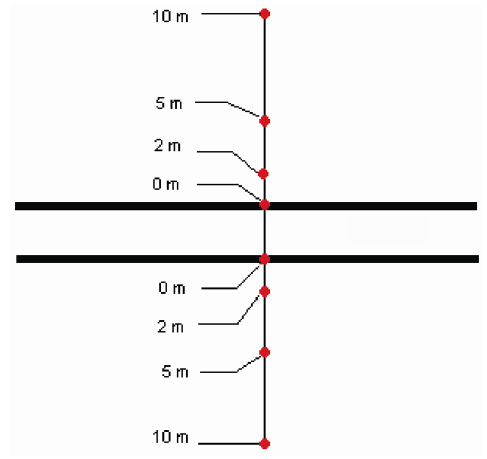
Fig. 1. Diagram of sample arrangement in the roadside transversal